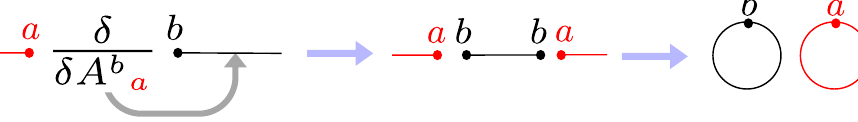
Figure 7 . The Ward identity on the Wilson loop. The insertion of r (cid:22) F (cid:22)(cid:23) on the loop can be replaced with the functional derivative (cid:14)=(cid:14)A (cid:23) . When it acts on other parts of the contour, it cuts the loop and reconnects it as shown in the